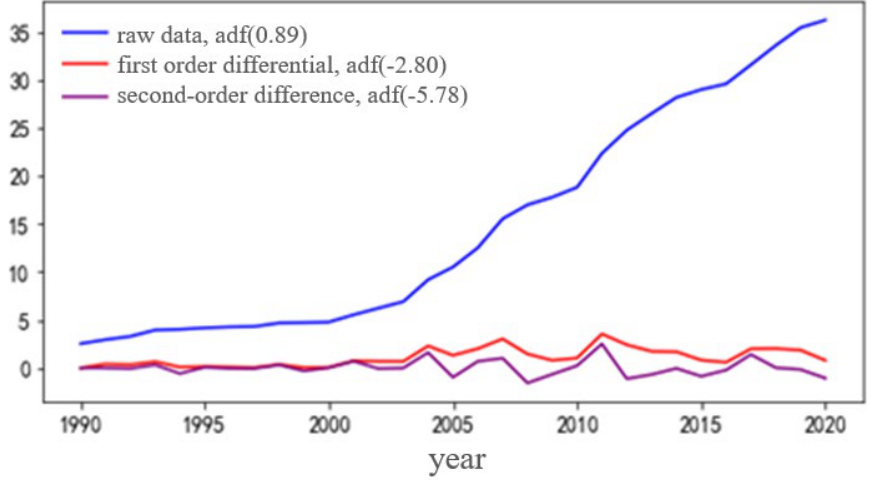
Figure 5. Load data stability detection.